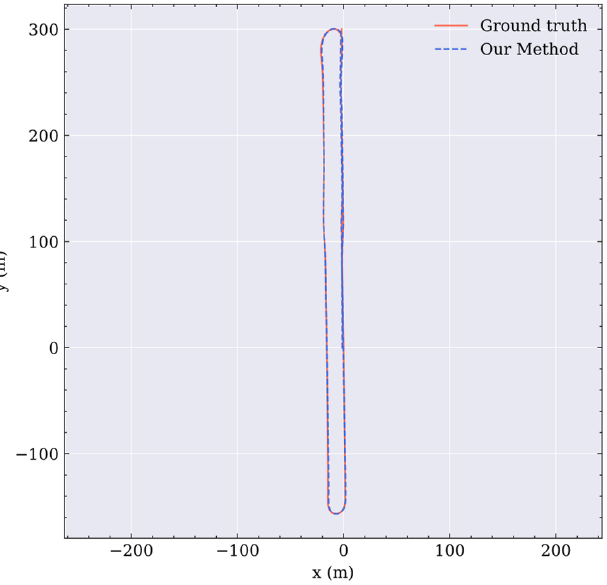
Figure 4. Trajectory of Seq. 06 in the KITTI dataset by the proposed LiDAR odometry.